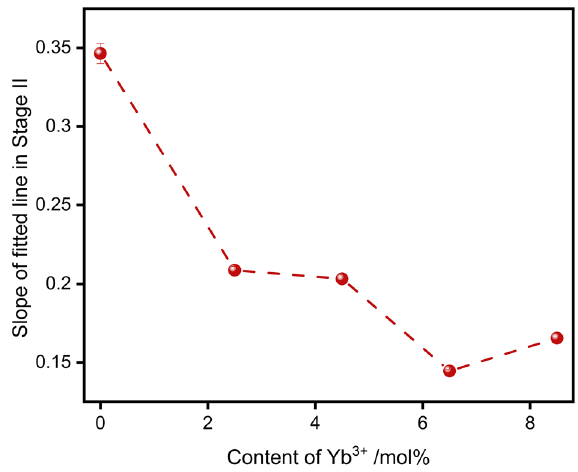
Figure 6. The slope of fitted line in Stage